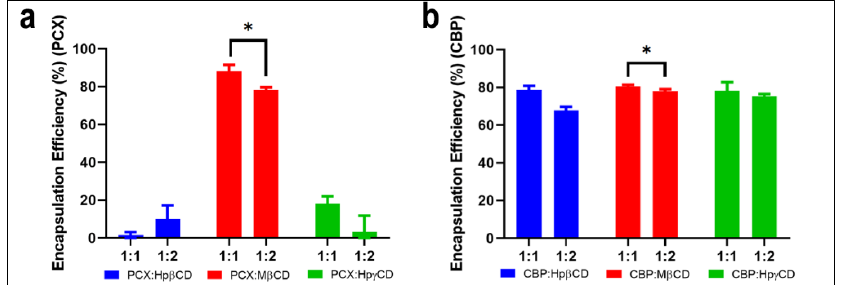
Figure 3. Encapsulation efficiency (%) of ( a ) PCX:CD ( b ) CBP:CD inclusion complexes (* the difference is signi fi cant, p < 0.05 (Student’s t-test), n = 3).